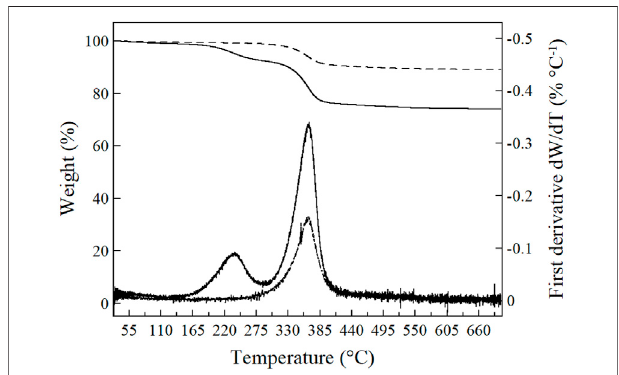
FIGURE 9 | TGA and fi rst derivative dW/dT curves of the coating before ( _ ) and after (--) immersion in SBF solution during 7 days.